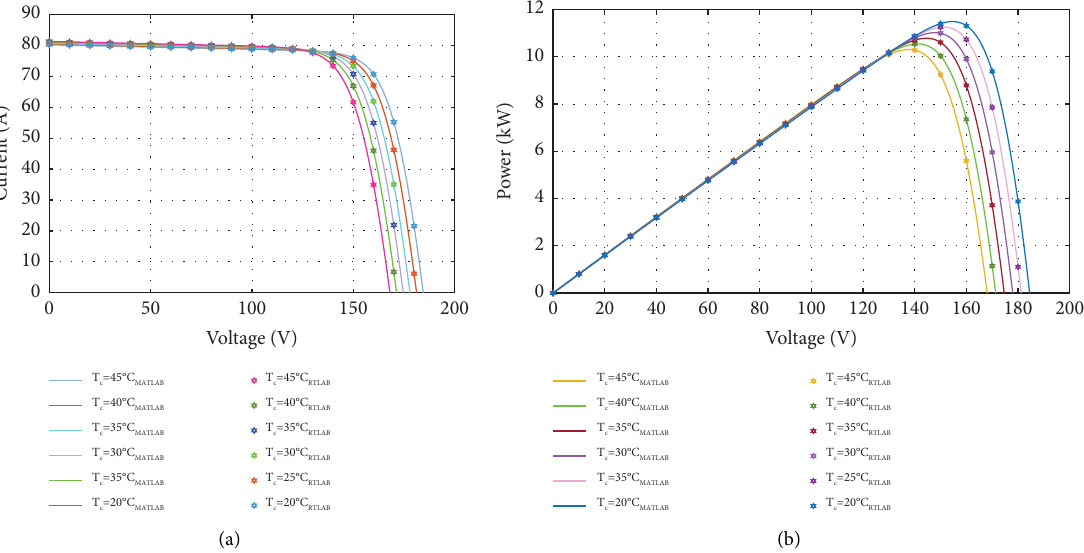
Figure 9: Output characteristic of each PV array obtained by RTLAB and MATLAB platforms under diferent temperatures when G � 1000W/m 2 : (a) I - U curves and (b) P - U